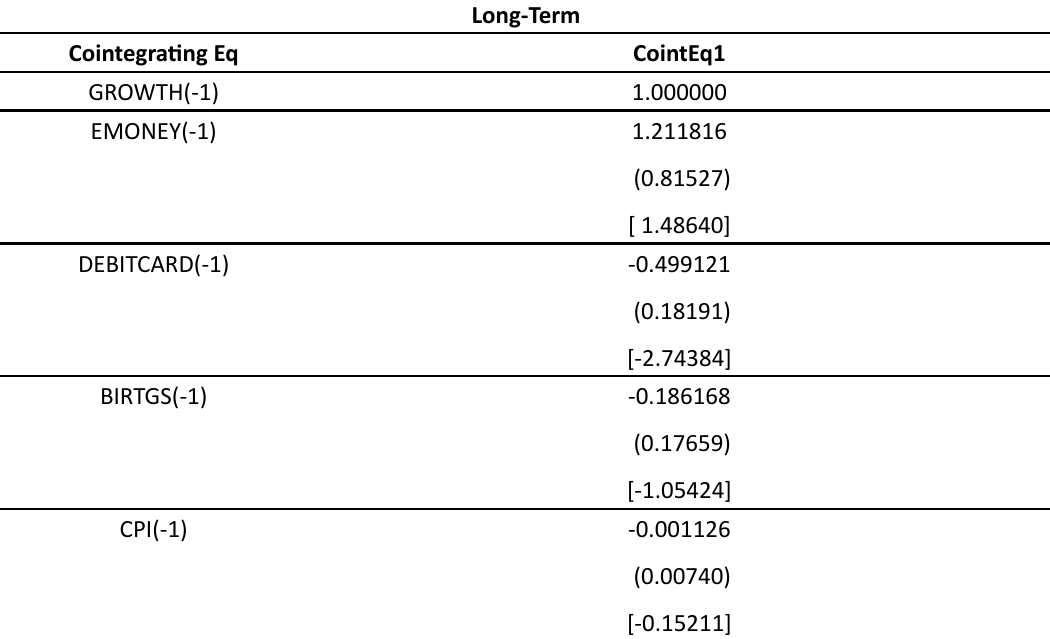
Table 6: The Results of VECM